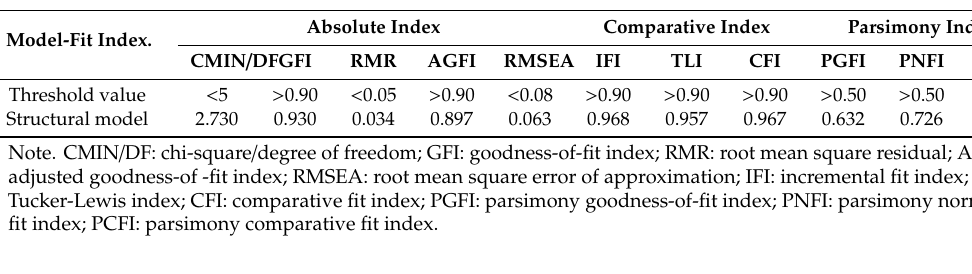
Table 4. Goodness-of-fit indexes.